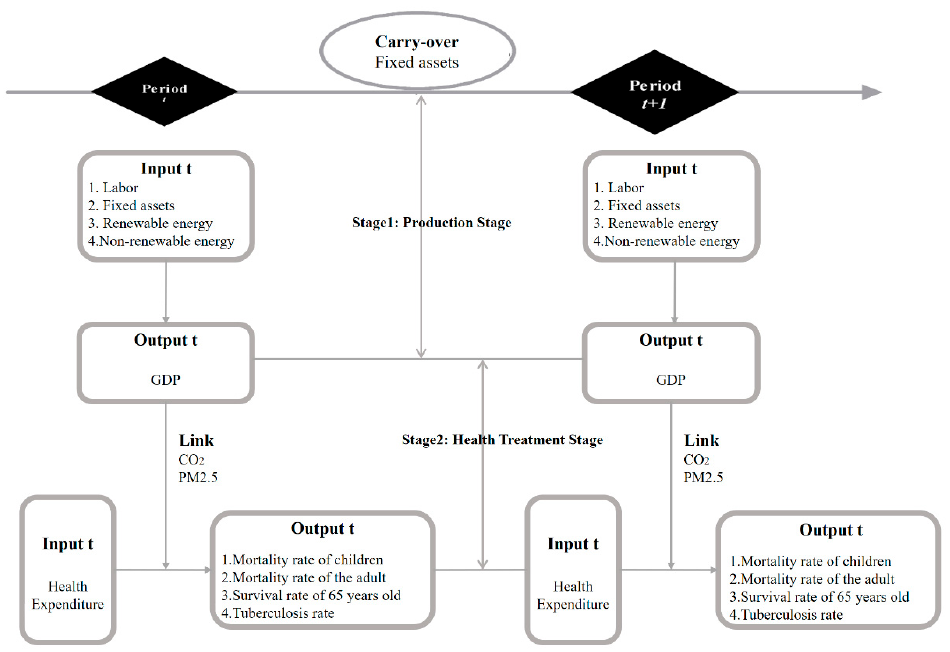
Figure 2. Two-stage meta dynamic network data envelopment analysis (DEA) model.